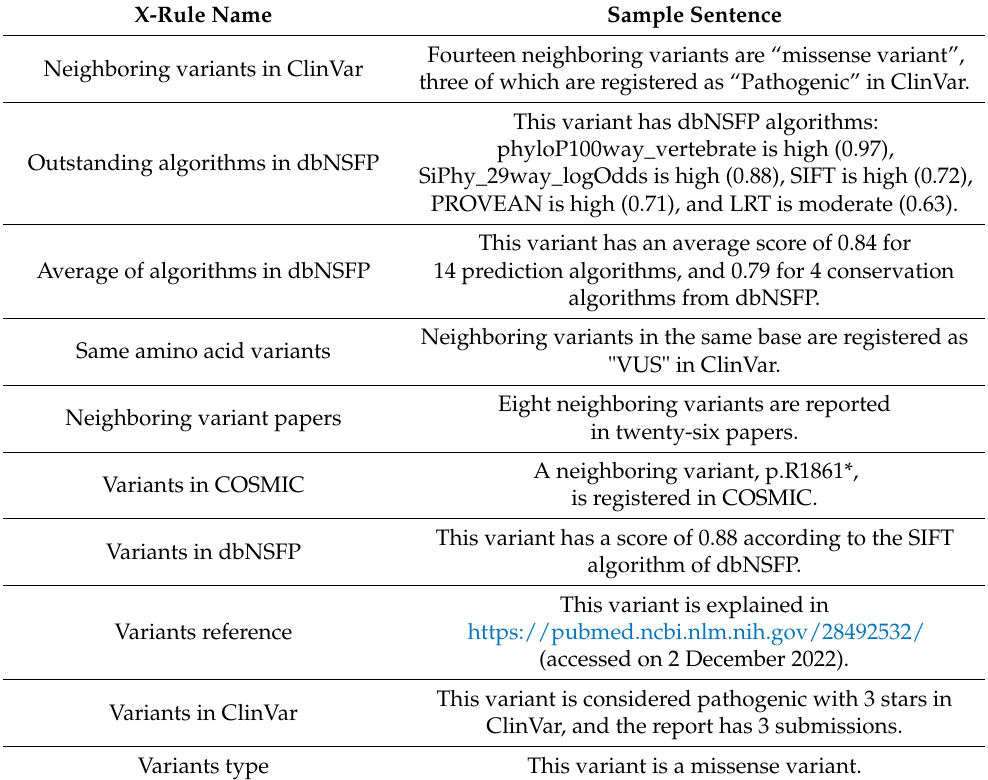
Table 1. This is the rule (X-Rule) for generating explanatory text with our proposed method. In "Variants in COSMIC", "*" in "p.R1861*" means mutation to any amino acid. The URL "https:// pubmed.ncbi.nlm.nih.gov/28492532/" of "Variants reference" was confirmed on 9 February